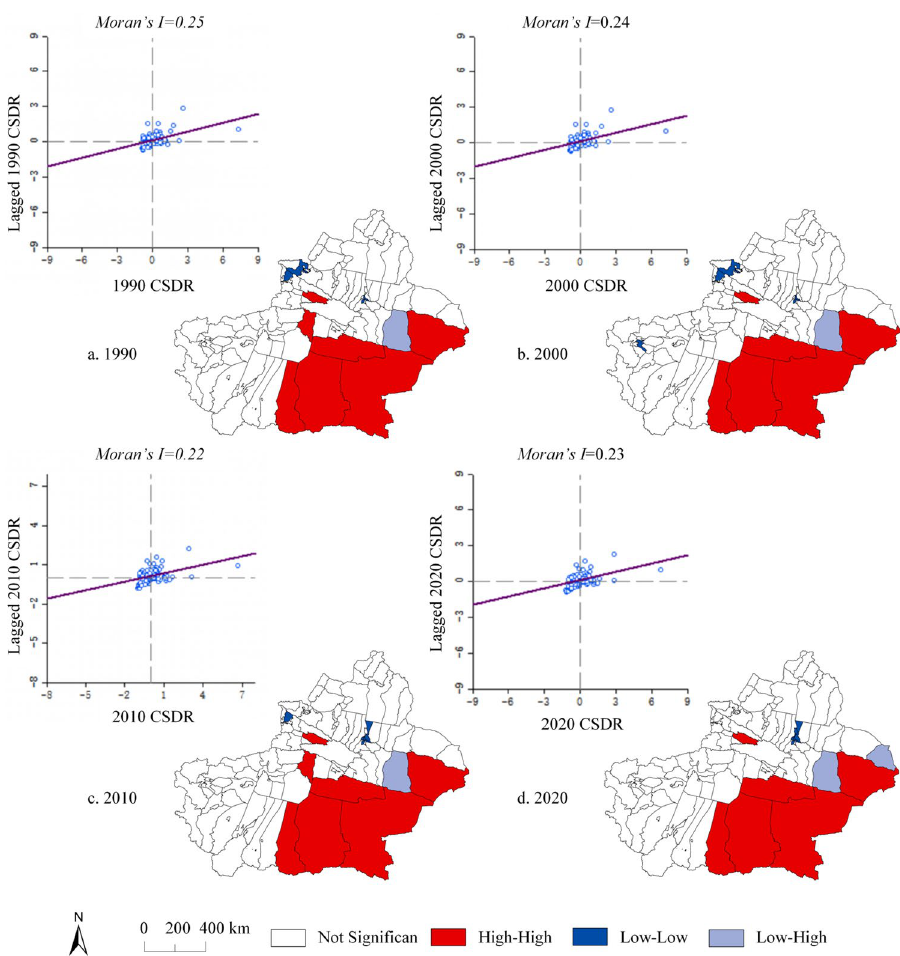
Figure 12. The Moran scatter and LISA cluster graph of CSDR in Xinjiang from 1990 to 2020. Map generated with ArcGIS 10.8 (ESRI). URL: https:// suppo rt. esri. com/ en/ Produ cts/ Deskt op/ arcgis- deskt op/